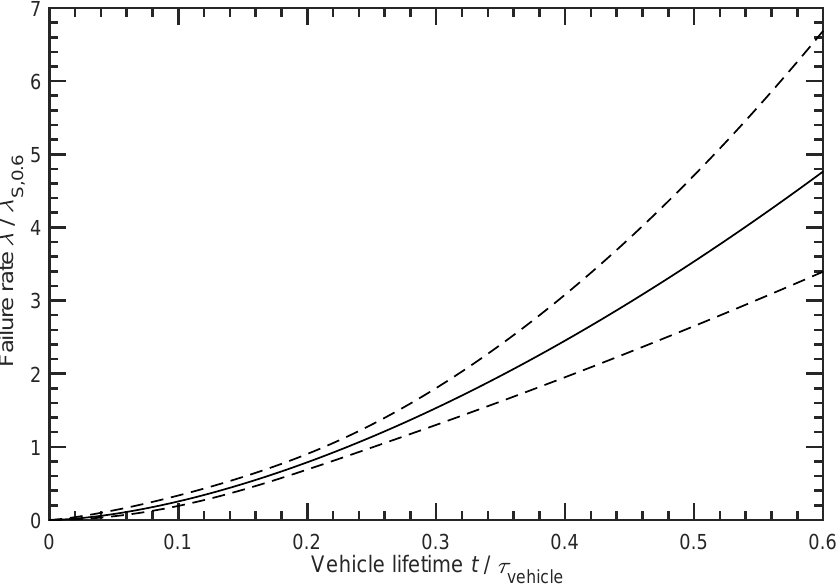
Figure 7. The normalised failure rate λ SC ( t ) of the failure mode Short Circuit with a shape parameter b = 2.637 and a normalised scale parameter T = 0.596 is shown. In addition, the upper and lower confidence limits for a confidence level of 95% are